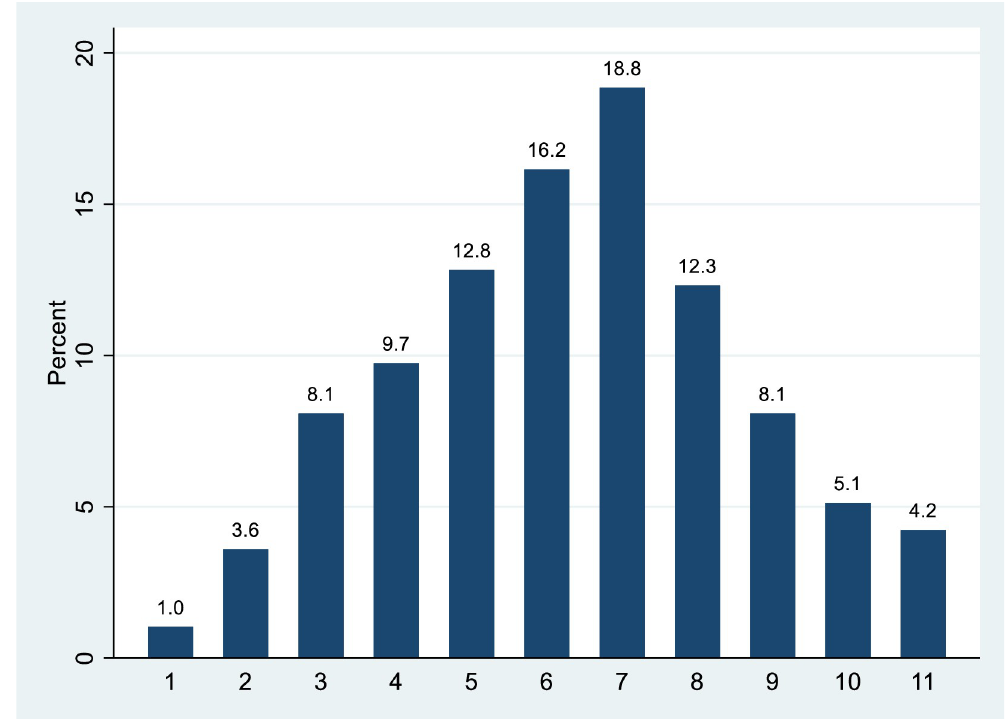
Fig 6. Percentage distribution of groups at one